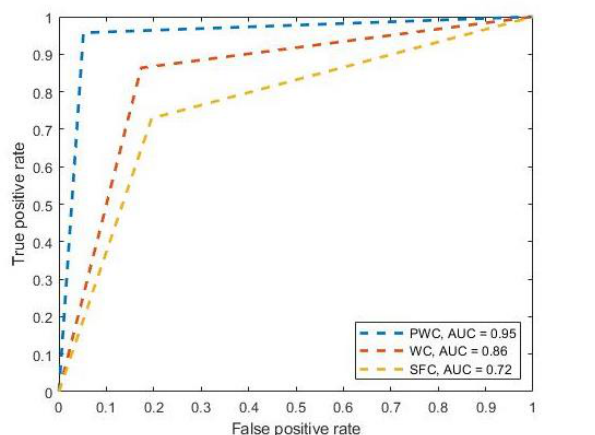
Figure 8. ROC curve and AUC of 3L-CNN using SFC, WC and PWC